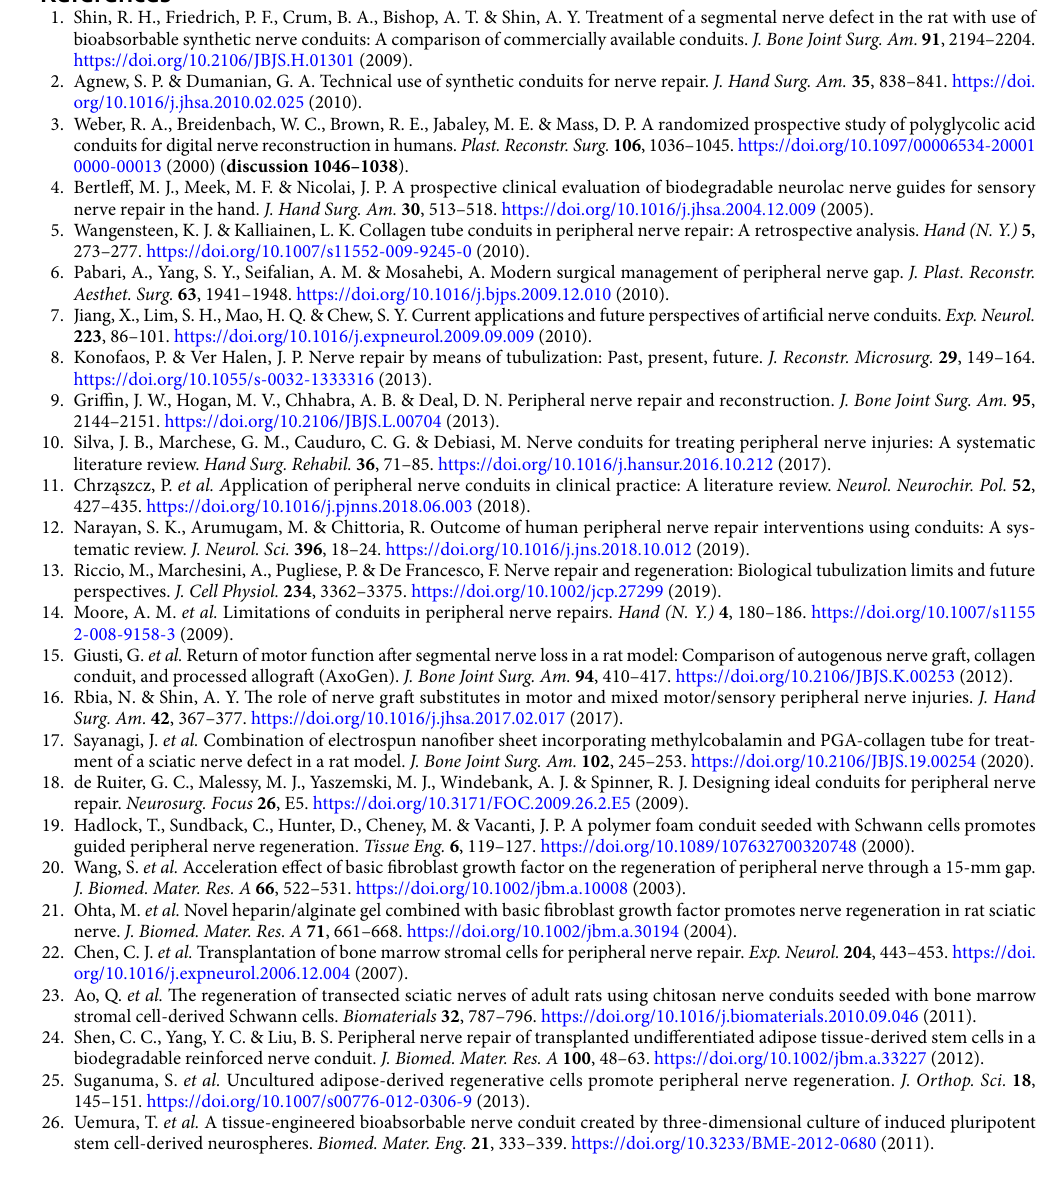
Nerve conduits three-dimensionally coated with the hiPSC-derived neurospheres containing neural stem/pro- genitor cells promoted axon regeneration and myelination histologically and improved functional recovery for nerve defects.